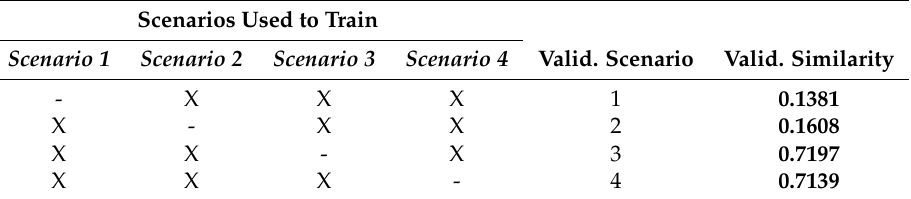
Table 3. The summary table with the scenarios used to configuring the simulator and the scenario used to validate